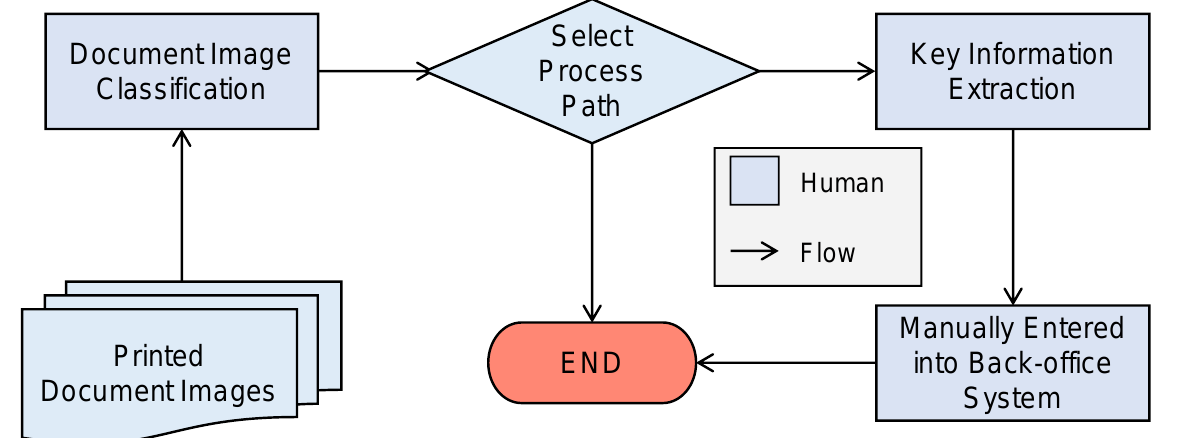
Figure 2. Original business process.